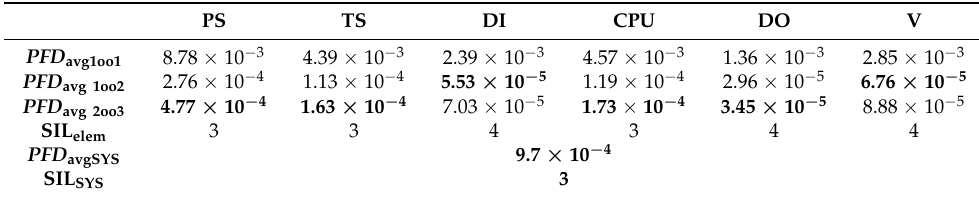
Table 11. Result for different E/E/PE architectures.